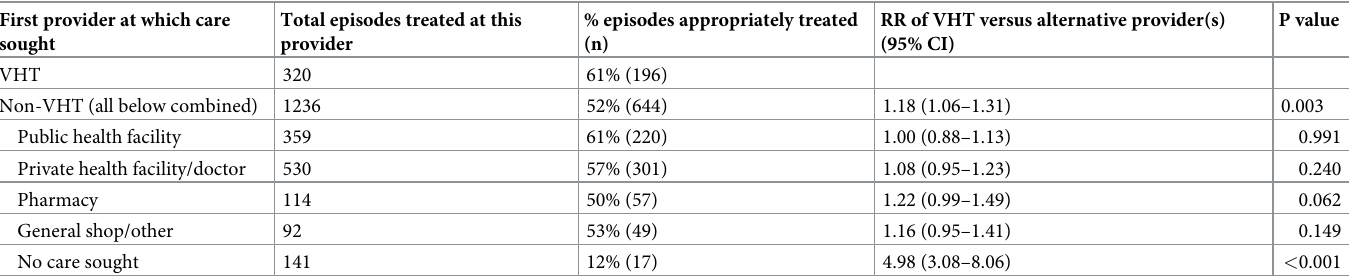
Table 8. Appropriate treatment of children with suspected pneumonia by first provider where care was sought. Significance tests compare appropriate treatment rate at the VHT (‘exposure group’) versus other provider types (‘null group’) in turn. First provider at which care Total episodes treated at this sought